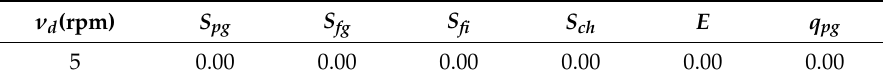
Table 4. Significance level for the ANOVA analysis.